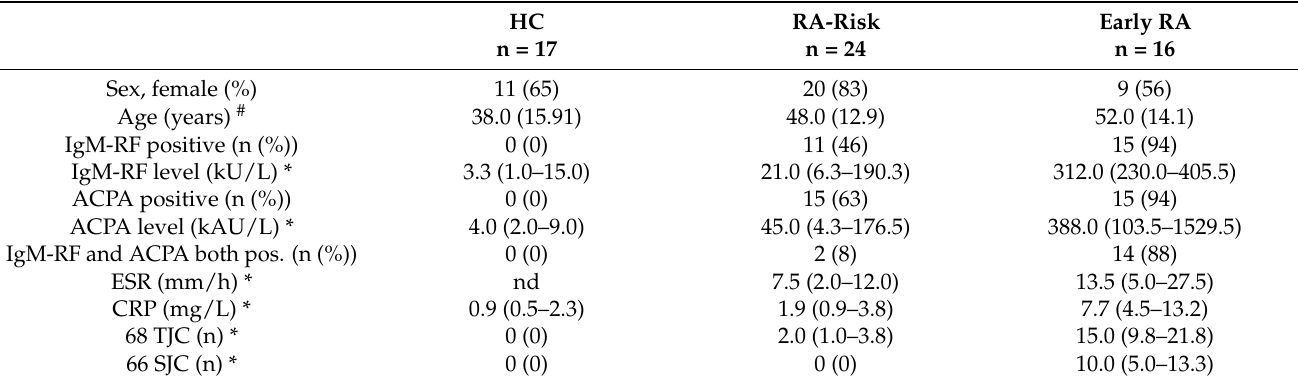
Table 1. Baseline characteristics of healthy controls (HCs), RA-risk individuals (RA-risk), and early RA patients (early